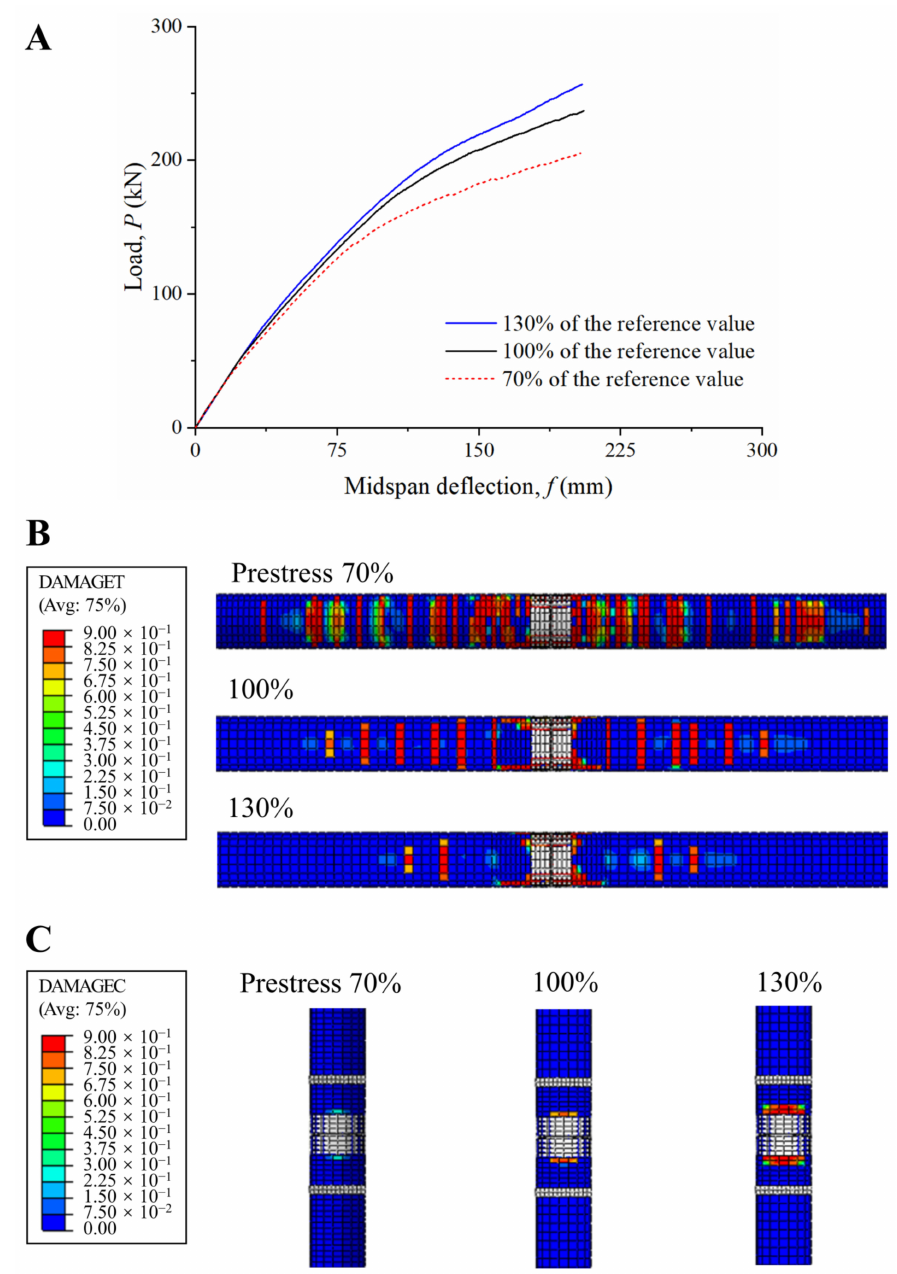
Figure 14. Influence of precompression stress of concrete on the bending strength of joints: ( A ) load- midspan deflection curves; ( B ) tension damage; ( C ) compression